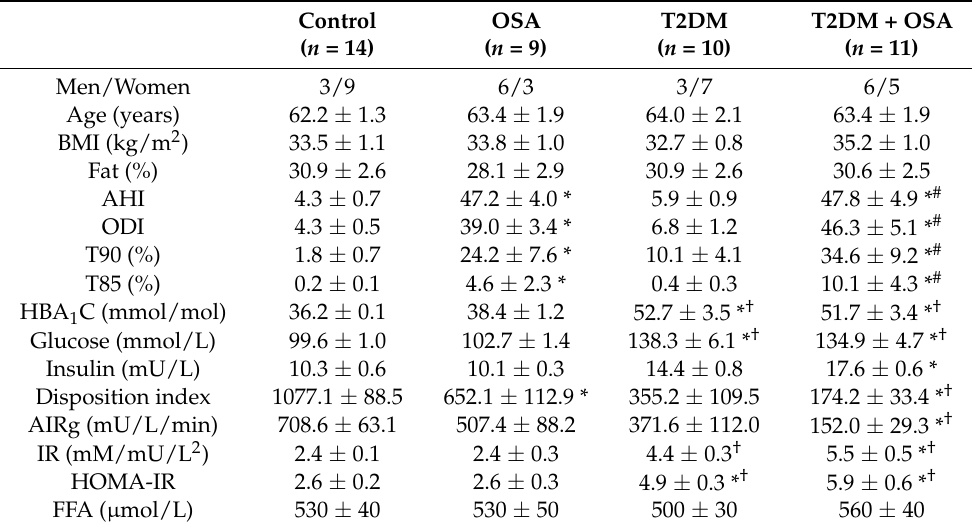
Table 1. Fundamental Anthropometric, Metabolic, and Sleep Characteristics of Subjects.